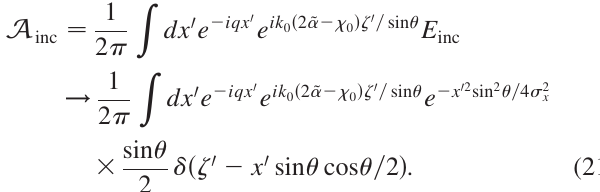
FIG. 2. Geometric relationship between the crystal coordinates ð x; ct Þ and the optical axis coordinates ð x reflected (top) and transmitted (bottom)